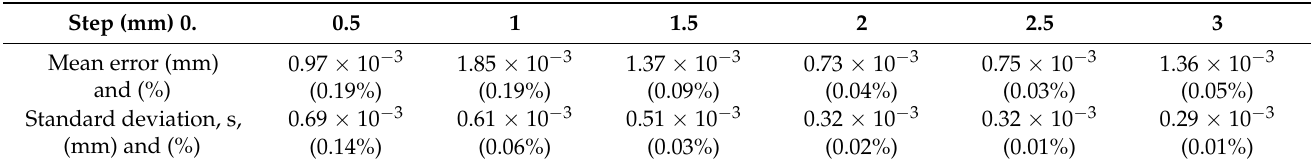
Table 2. Results of the mean and the variance of the measurement differences between 3D DIC and LVDT for each displacement